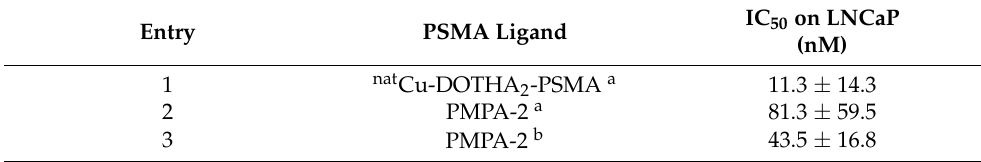
Table 2. Affinities of PSMA ligands for PSMA on the LNCaP human prostate cell